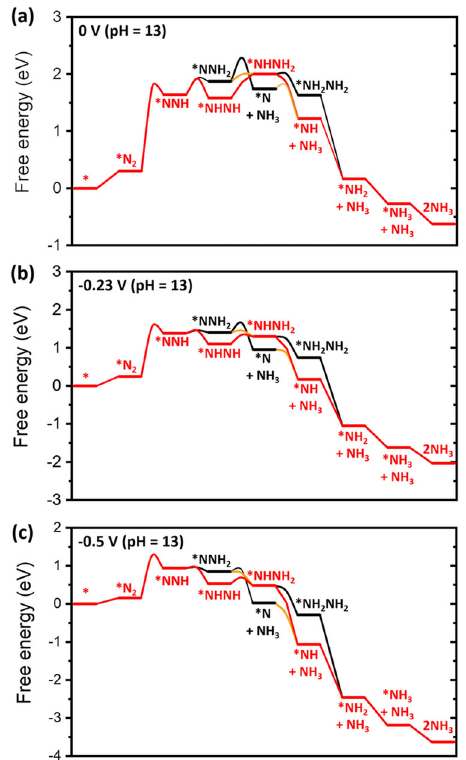
Fig. 3 Free energy diagram of NRR including activation energy. Free energy diagram of NRR (pH = 13) at a U = 0 V vs. RHE, b U = − 0.23 V vs. RHE, and c U = − 0.5 V vs. RHE. The lowest activation energy requiring reaction pathway is represented by red